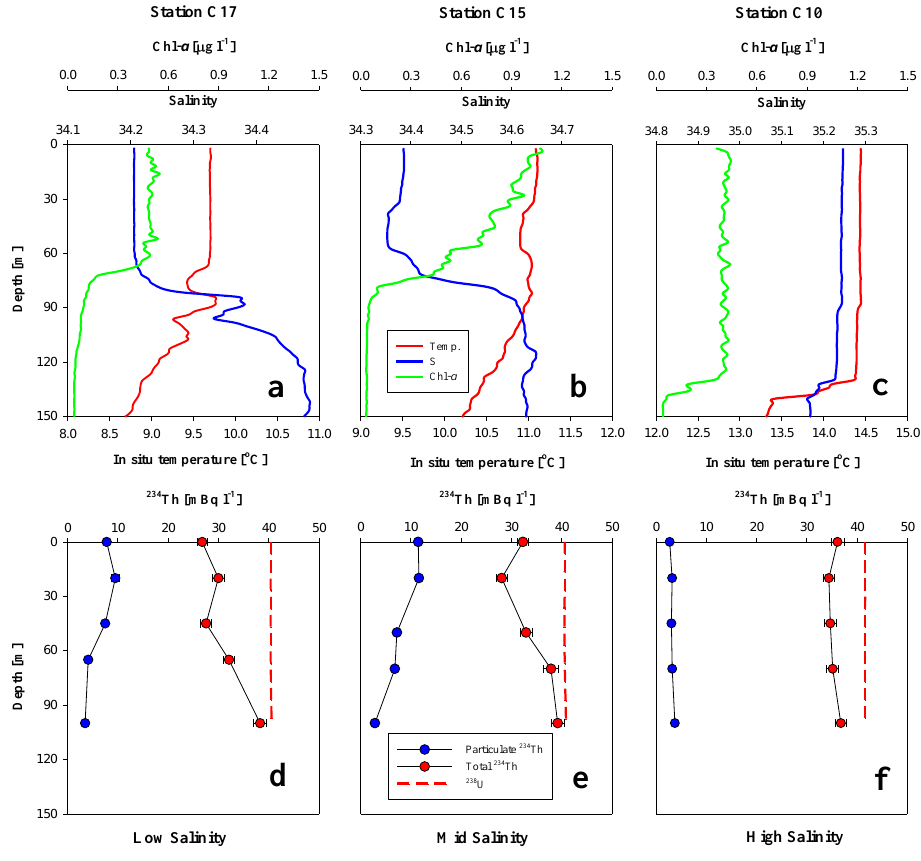
Fig. 4. (a) , (b) , and (c) Vertical profiles of temperature, salinity and Chl- a in the upper 100 m at stations C17, C15, and C10, respectively. (c) , (d) , and (e) Vertical profiles of particulate and total 234 Th from the same stations. Fig.5